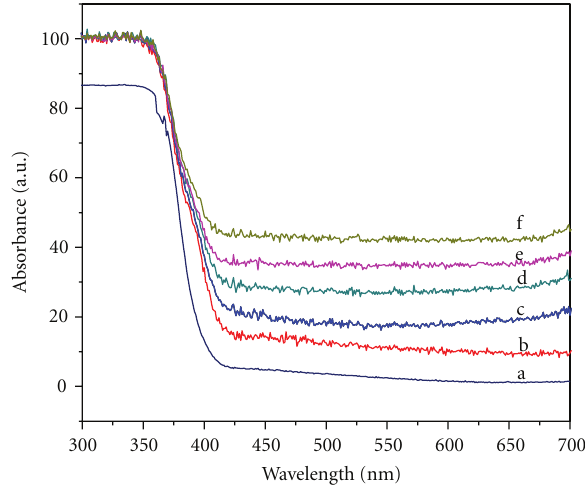
Figure 4: UV-Vis di ff use reflectance spectra of di ff erent photocatalysts. (a) TiO 2 , (b) F-TiO 2 , (c) CuO(0.1wt.%)/F- TiO 2 , (d) CuO(0.3wt.%)/F-TiO 2 , (e) CuO(0.5wt.%)/F-TiO 2 , (f) CuO(1wt.%)/F-TiO